Question: Describe this figure in one sentence.
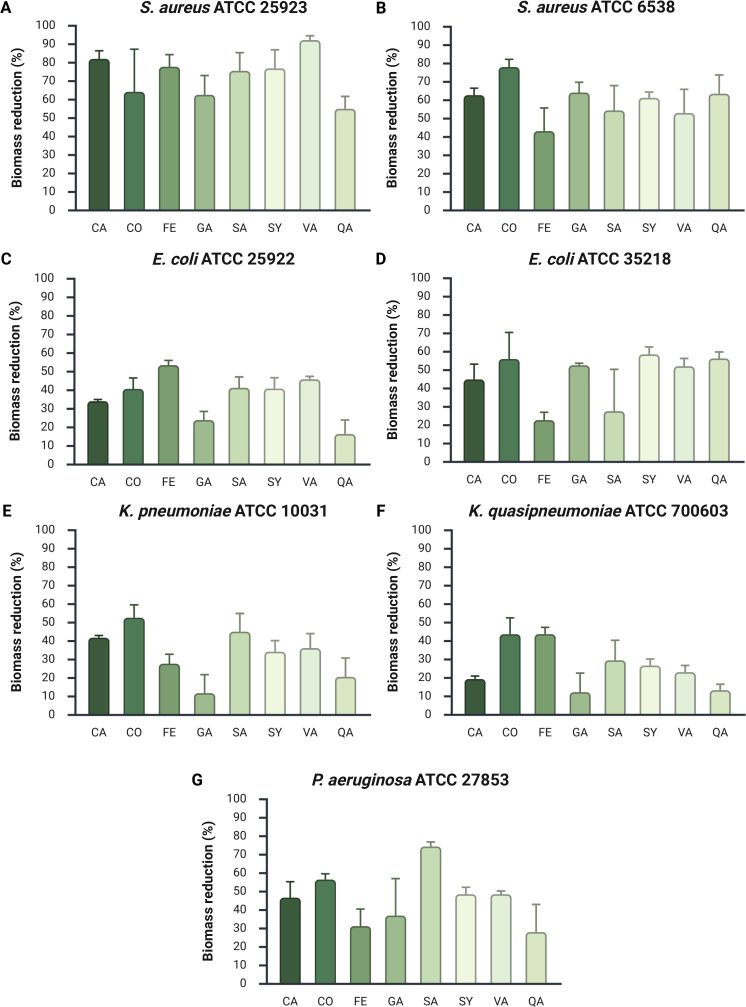
Answer: Biofilm biomass reduction (%) at concentration 2 × MIC. ( A ) S. aureus ATCC 25923; ( B ) S. aureus ATCC 6538; ( C ) E. coli ATCC 25922; ( D ) E. coli ATCC 35218; ( E ) K. pneumoniae ATCC 10031; ( F ) K. quasipneumoniae ATCC 700603; ( G ) P. aeruginosa ATCC 27853. CA—caffeic acid; CO —p -coumaric acid; FE—ferulic acid; GA—gallic acid; SA—salicylic acid; SY—syringic acid; VA—vanillic acid; QA—quinic acid. Created in BioRender. Bārzdiņa, A. (2026) https://BioRender.com/hsropid .